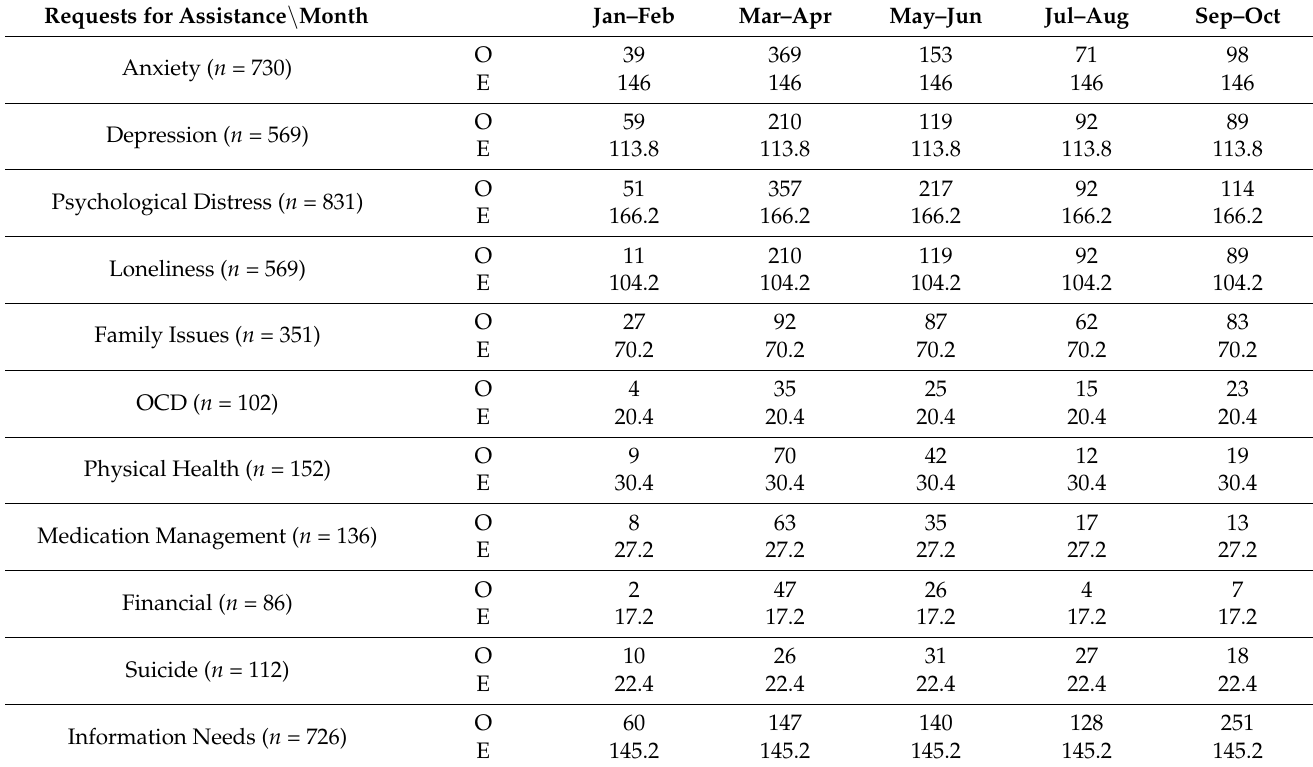
Table 2. Trends in calls for assistance made during the Pre-COVID and COVID